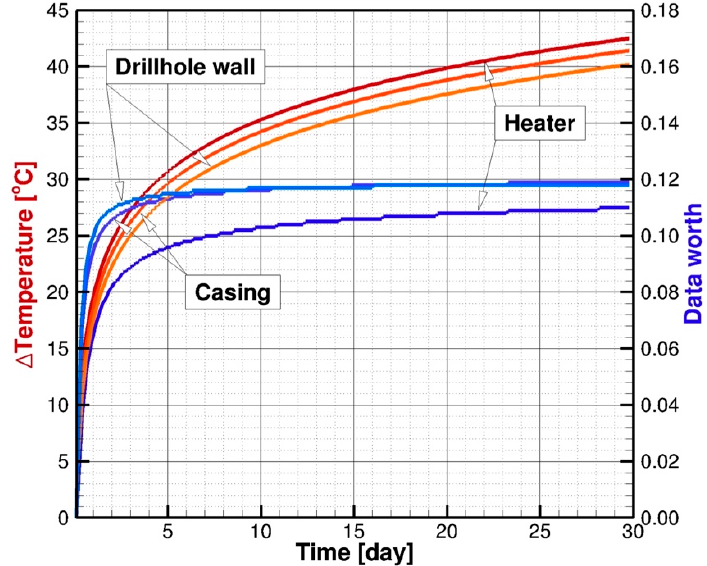
Figure 7. Temperature increase and data-worth metric for distributed temperature sensors installed at different locations within the drillhole as a function of time.